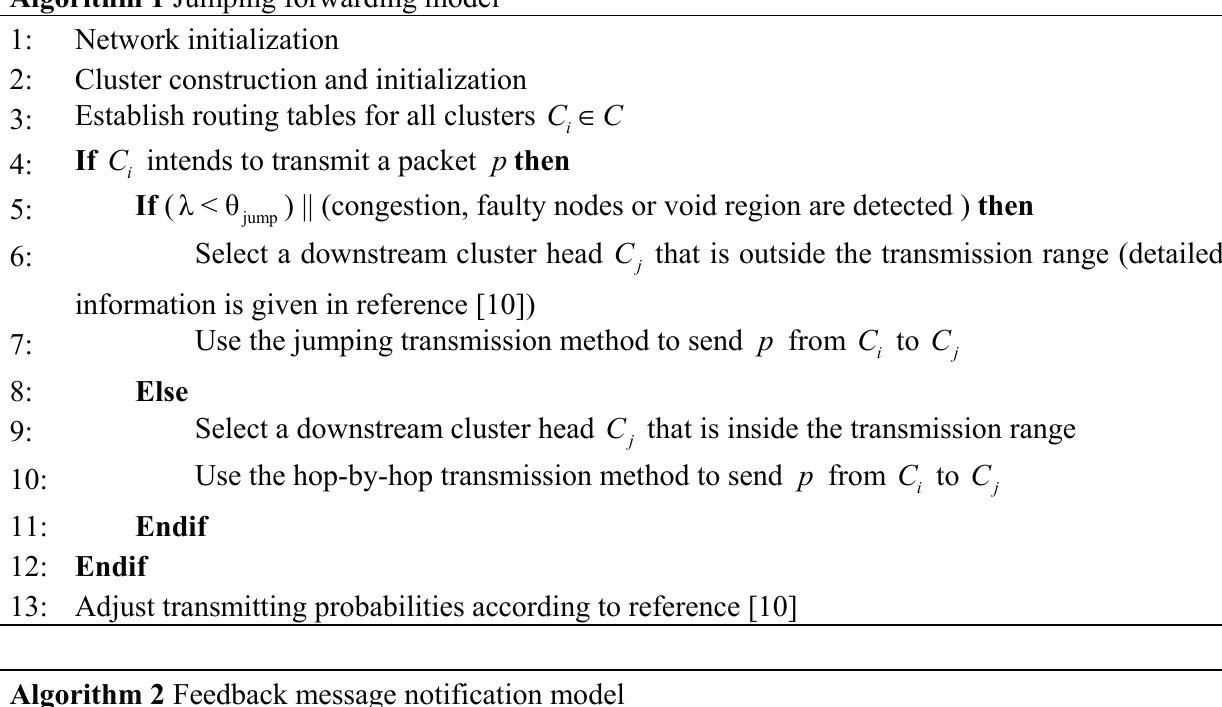
Algorithm 2 Feedback message notification